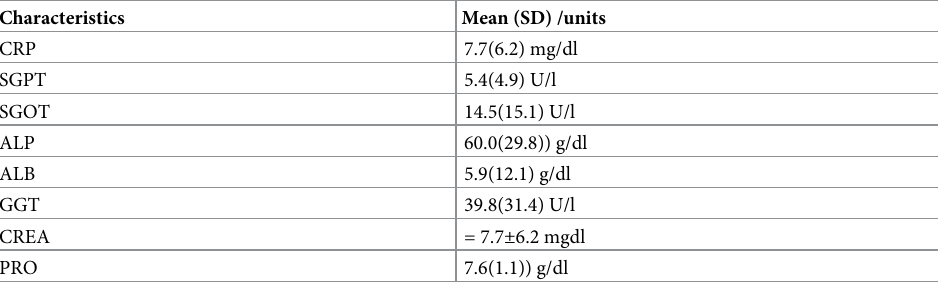
Table 3. Showing the biochemical parameters the active TB patients.